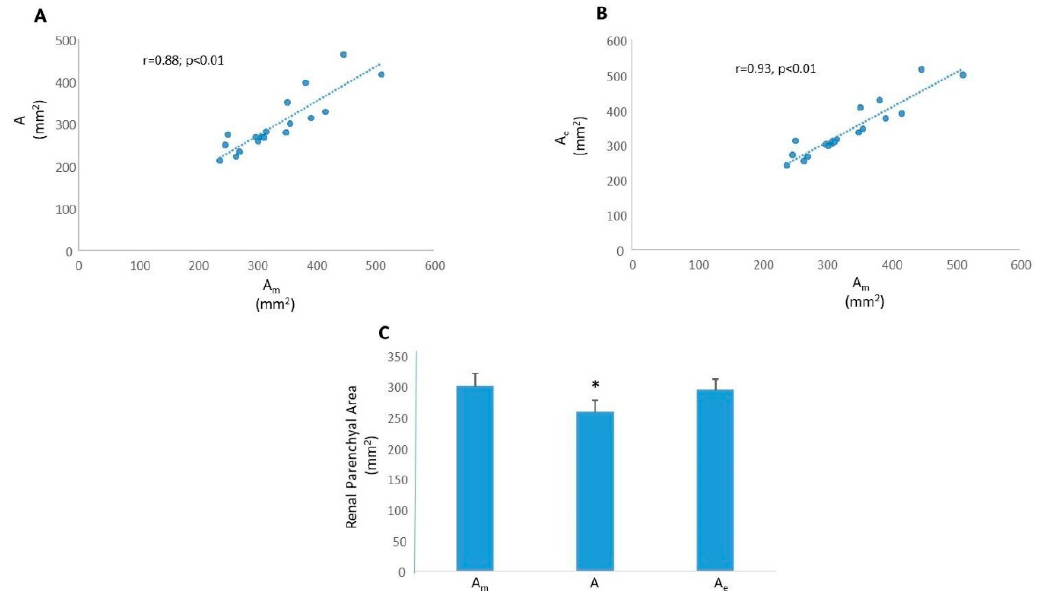
Figure 3. Left kidney parenchymal area in healthy and diseased rats. Left kidneys were sourced from adult male and female obese ZSF1 rats, adult male SD rats and adult male SD rats administered PAN and sliced coronally. ( A ) A scatter plot of A , the renal parenchymal area calculated using the existing ellipse-based formula vs. A m , the measured renal parenchymal area. ( B ) A scatter plot of A e , the renal parenchymal area calculated using the modified ellipse-based formula with the extended minor axis vs. A m , the measured renal parenchymal area. ( C ) In coronal renal slices, A m is greater than A (*, p < 0.01) but not different from A e .